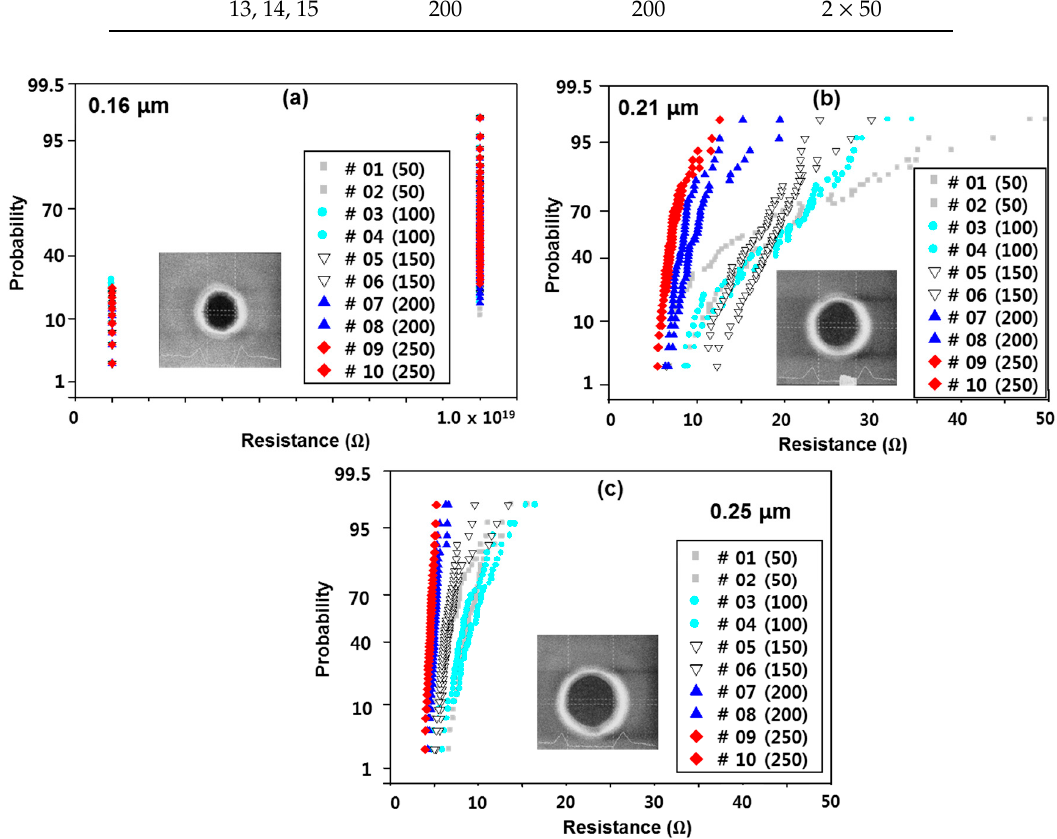
Figure 5. etch critical demension (FICD) SEM image of ( a ) 0.16, ( b ) 0.21 and ( c ) 0.25 via 1 insistence (minimum width via pattern).